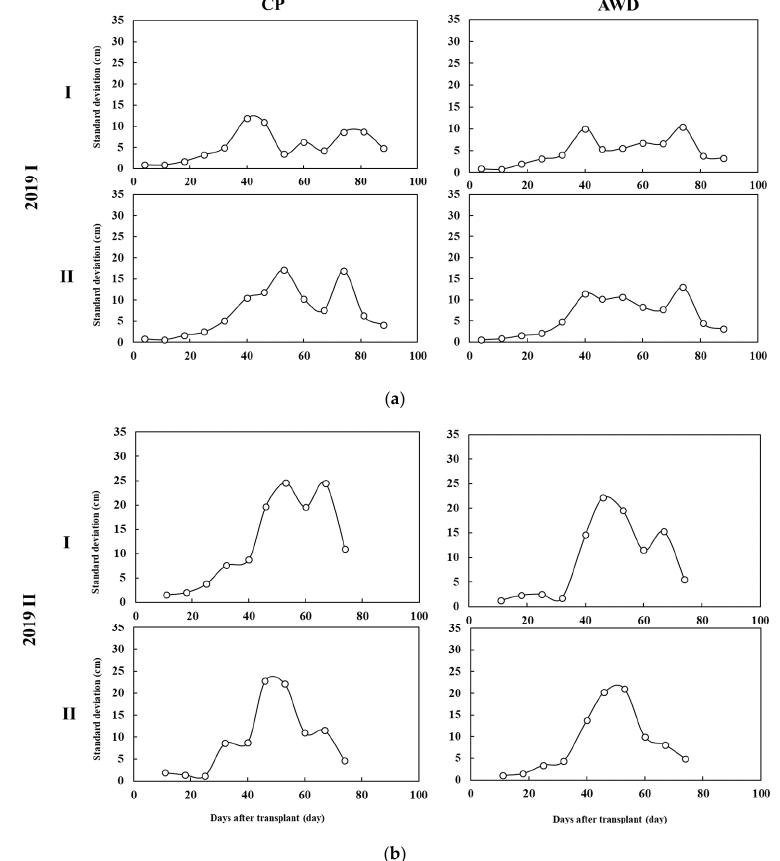
Figure 17. Standard deviation of UAV plant height in ( a ) the first and ( b ) the second crop seasons under different water treatments (CP and AWD).